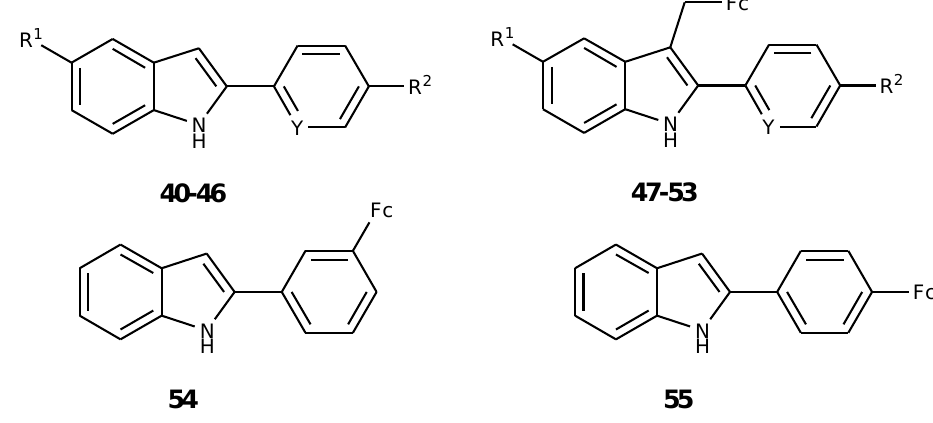
Figure 17. Chemical structure of indole ( 40 – 46 ) and ferrocene – indole derivatives ( 47 – 55